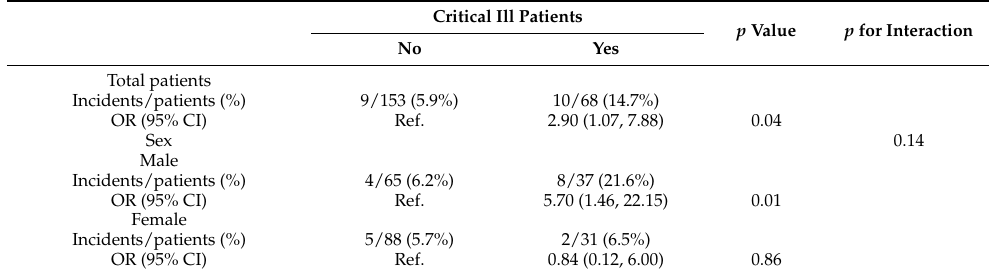
Table 5. Associations of COVID-19 severity with risk of diabetes incidence after